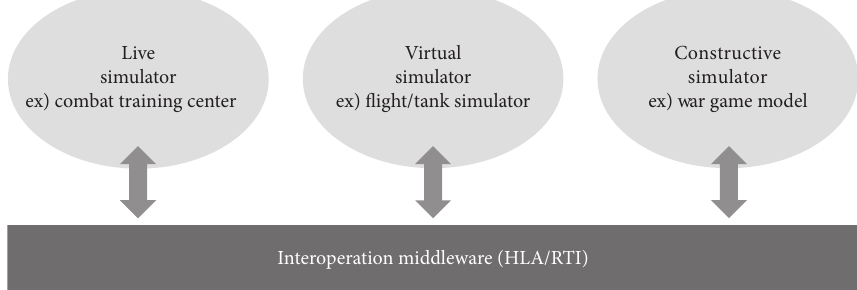
Figure 1: Concept of LVC interoperation.